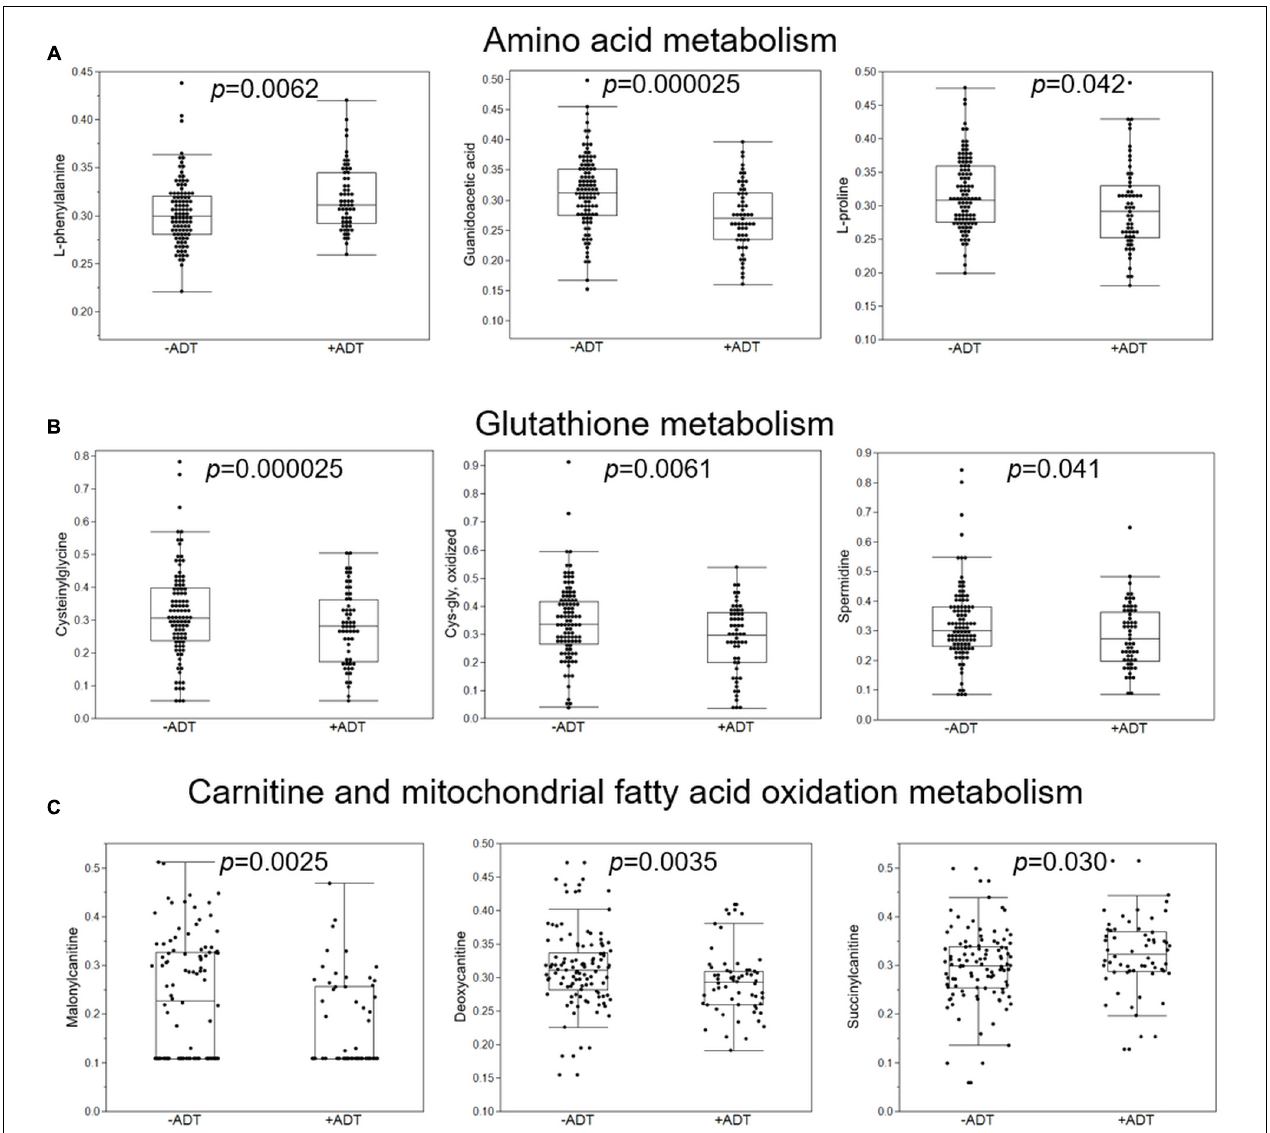
FIGURE 3 | Additional metabolic pathways that were overrepresented by metabolites significantly distinguished the +ADT from the − ADT group. (A) Box plots of individual metabolites related to amino acid metabolism. (B) Box plots of individual metabolites related to glutathione metabolism. (C) Box plots of individual metabolites related to carnitine and mitochondrial fatty acid oxidation